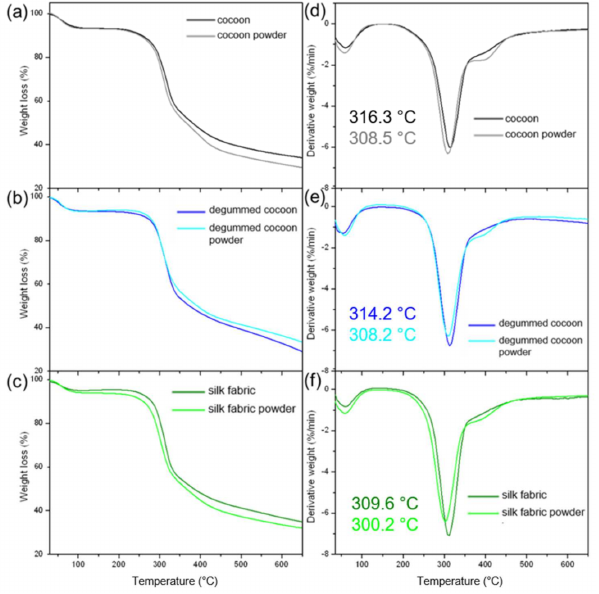
Figure 8. ( a – c ) TG and ( d – f ) DTG thermograms of ( a , d ) raw and ( b , e ) degummed silk co- coons, and ( c , f ) silk fabric, and silk powders from ( a , d ) raw cocoons, ( b , e ) degummed cocoons, and ( c , f ) silk